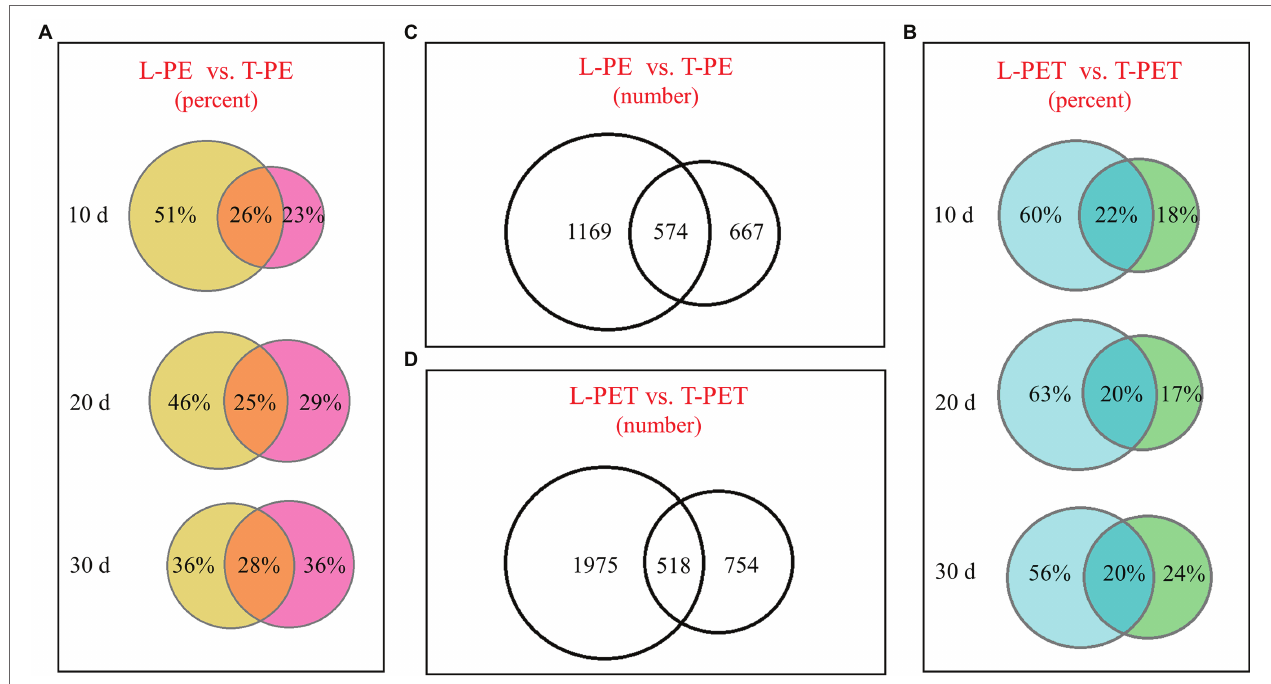
FIGURE 1 | Venn diagrams showing the operational taxonomic units (OTUs) number or percentage of microplastic-biofilms (MPBs). (A,B) The OTUs percentage of polyethylene (PE) and polyethylene terephthalate (PET) biofilms incubated with lake and tap water at t = 10, 20, and 30 days; (C,D) the OTU number of MPB sample